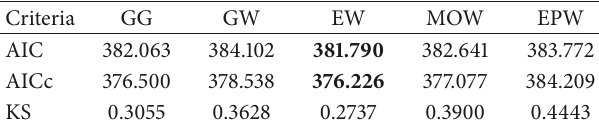
Table 6: Results of AIC and AICc criteria and the 𝑝 value from the KS test for all fitted distributions considering the Pricker B. Criteria